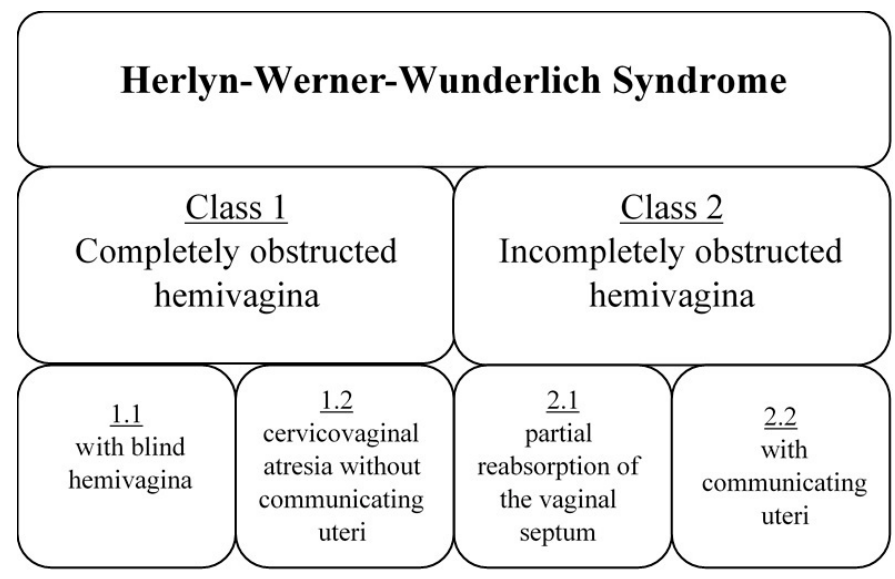
Figure 2. Classification of Herlyn-Werner-Wunderlich Syndrome (HWWS), based on Zhu et al. [11]. According to this classification, the 17-year-old patient should be qualified as sub-class 2.1, and the 13-year-old as 1.1 (Figure 3).